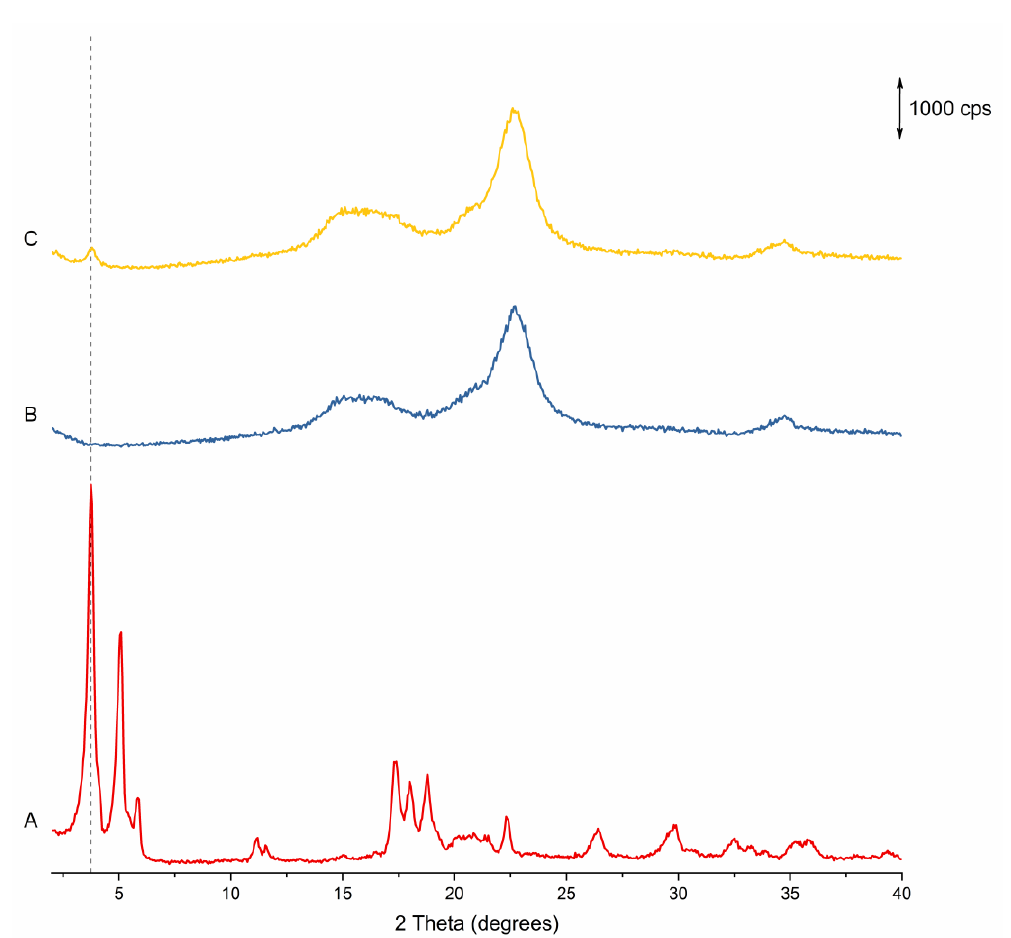
Figure 6. pXRD diffractograms for the materials used and produced in the fluidized bed coating study. ( A ) sodium ibuprofen (anhydrous), ( B ) uncoated MCC beads and ( C ) coated beads. The reference line is at 3.75 degrees (2θ) .